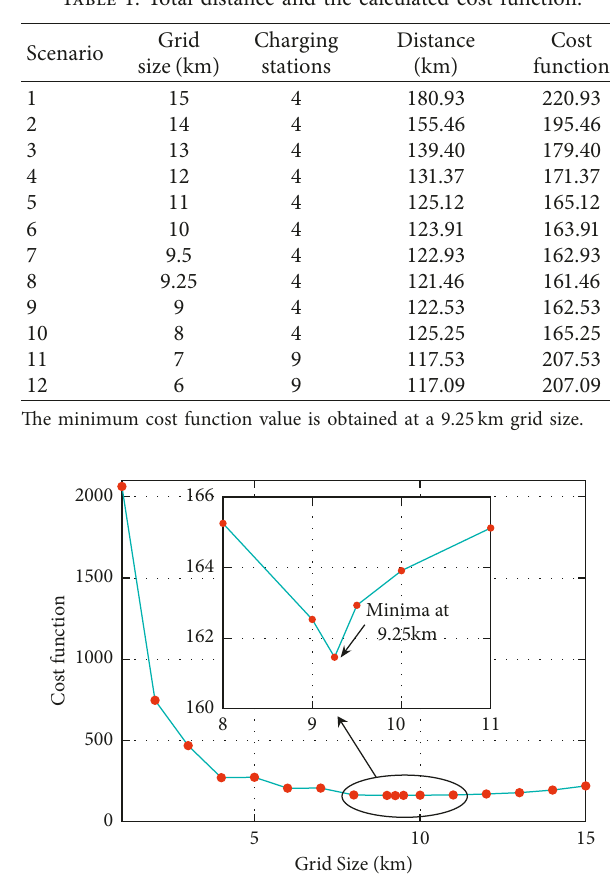
Figure 10: The graph of the grid size versus the cost function. At a grid size value of 9.25km, we get the